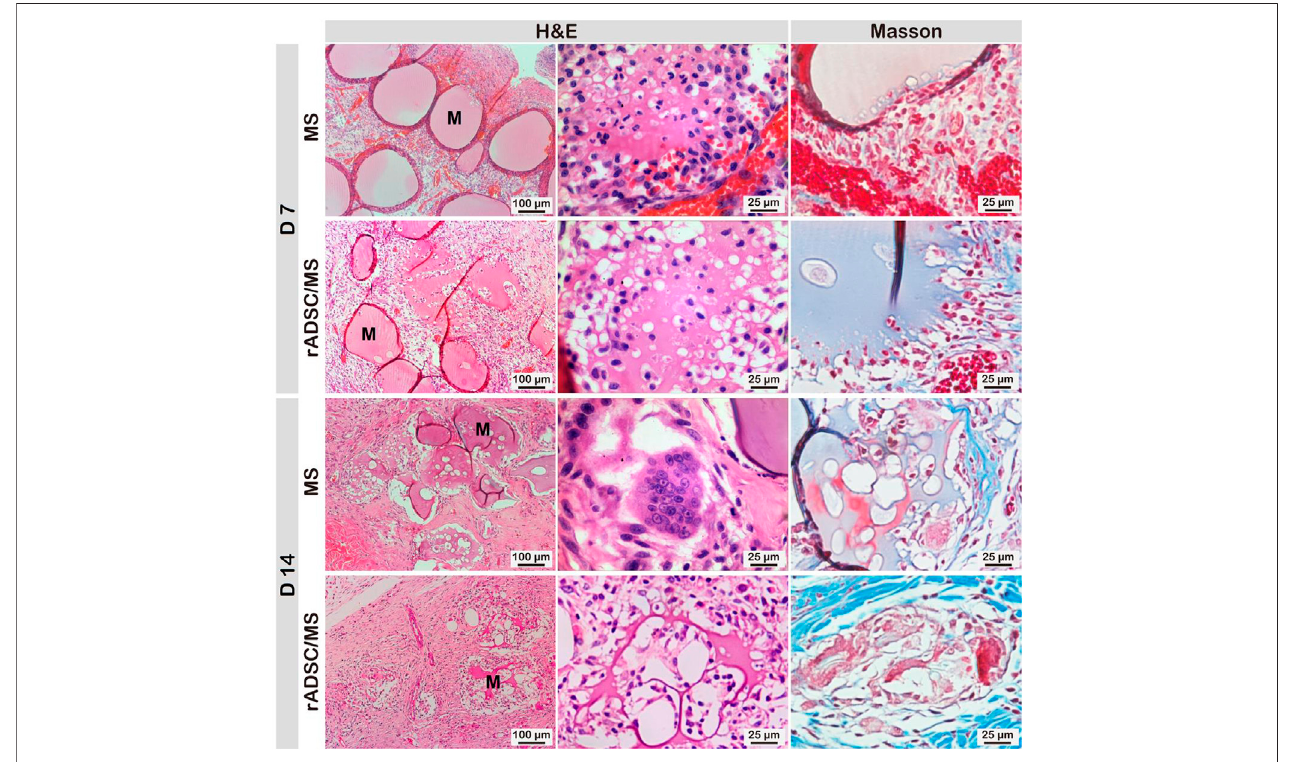
FIGURE 5 | Biocompatibility and biodegradability of gelatin microspheres during wound healing. Degradation rate of microspheres in rADSC/MS group appeared to be faster than that in MS group. “ M ” represents gelatin microspheres.